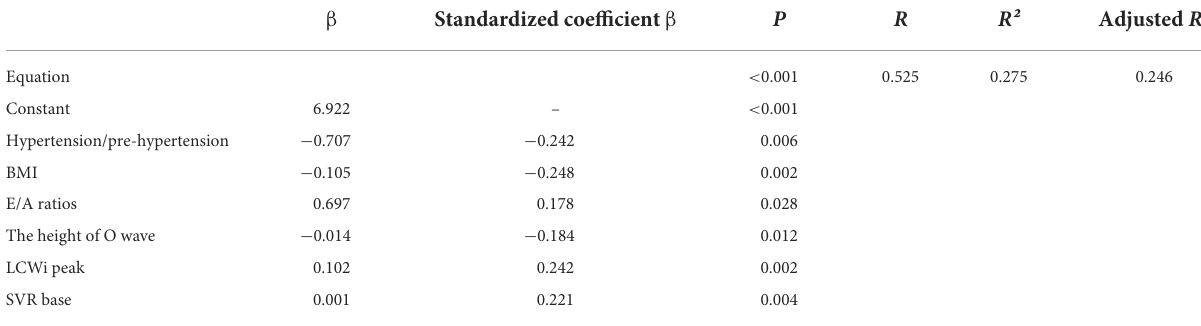
TABLE 5 The multiple linear regression results between METs max and the independent variables